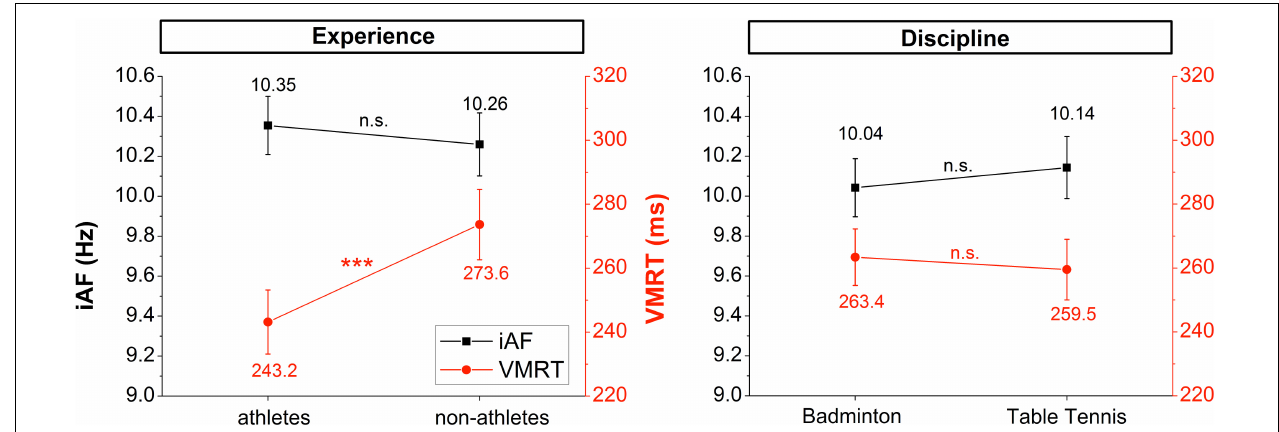
FIGURE 3 | Group comparisons of IAF (black lines) and VMRT (red/gray) lines for the parameter “experience” (athletes vs. non-athletes) and “discipline” (badminton players vs. table tennis players. Error bars reflect 95% confidence intervals. n.s. = not significant, *** p < 0.001. TABLE 3 | Results of the multiple regression analysis predicting the IAF in the three cortical regions of interest.